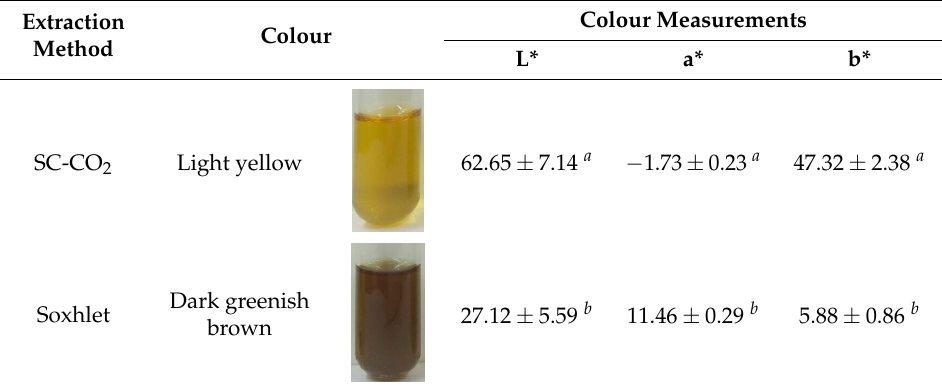
Table 3. Colour (CIELab) of Gac seed oils extracted by SC-CO 2 and Soxhlet.